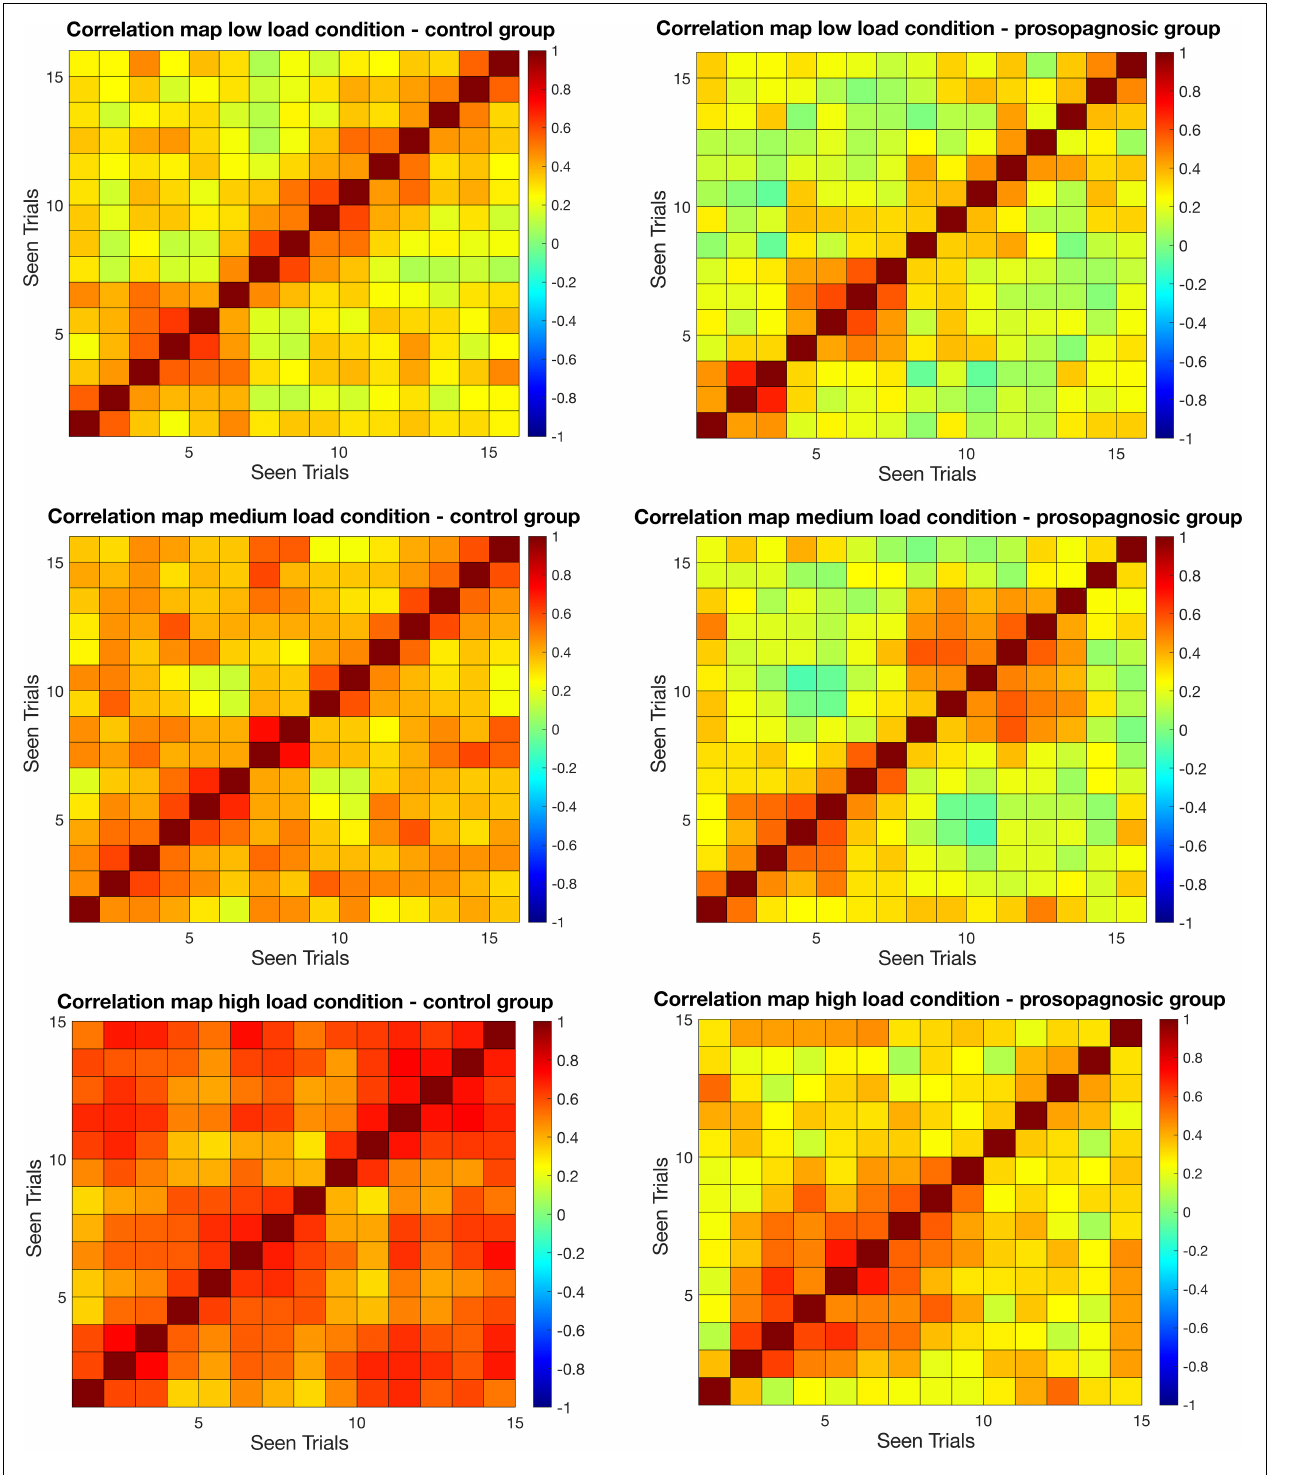
FIGURE 3 | Mean correlation matrices for control and prosopagnosic group for different memory conditions for the maintenance phase. On the x and y axes, correctly answered trials in chronological sequence ordered by seen are represented. Seen is defined by the chronological order by which trials are presented to the